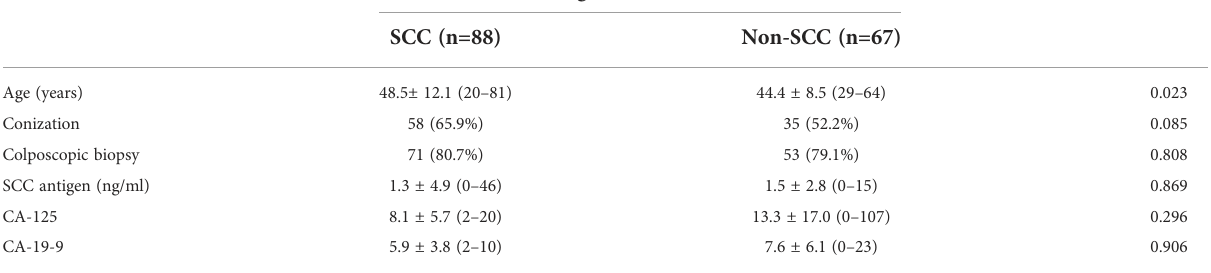
TABLE 1 Demographics in patients with IB1 SCC and non-SCC cervical cancers.